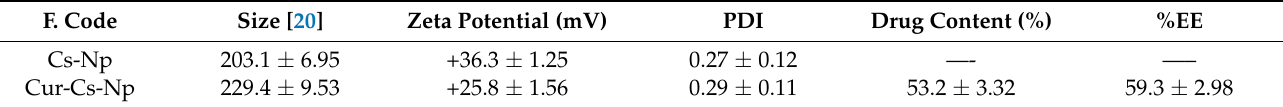
Table 1. Characterization of nanoparticles.